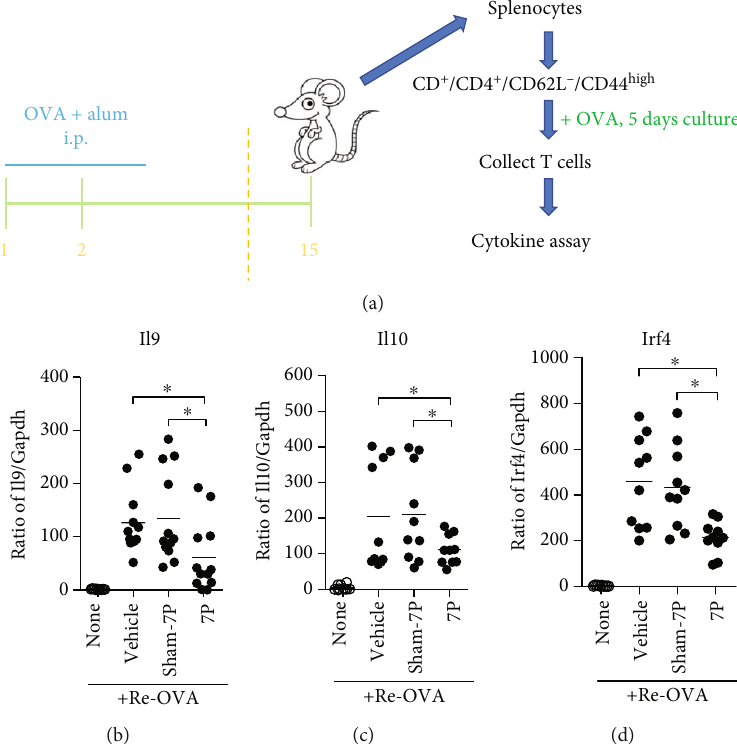
Figure 3: Suppression of Th9 cell di ff erentiation from memory CD4 + T cells by 7P. (a) To determine whether 7P could inhibit memory CD4 + T cells, 6 – 8-week-old mice were immunized with OVA and alum (2 μ g OVA/mouse) twice on days 1 and 2. After 14 days, CD3 + CD4 + CD62L - CD44 +high CD45RO + T cells (memory CD4 + T cells) from the collected spleen were isolated and restimulated by OVA with 7P, sham-7P, or vehicle for 4 – 5 days. (b – d) RNA was isolated from cells, and Il9 Il10 lrf4 mRNA was quanti fi ed by qPCR. Data were expressed as mean ± standard errorof the mean (SEM; n = 10 mice/group from 1 to 3 independent experiments). ∗ p < 0 : 05 compared with sham-7P and vehicle-treated